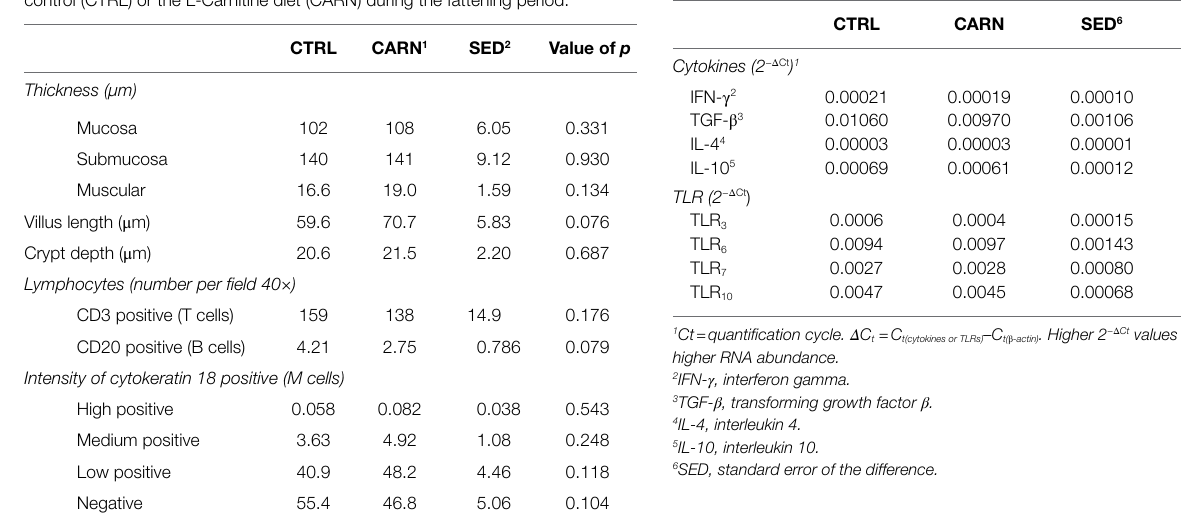
TABLE 9 | Cytokines and toll-like receptors (TLRs) mRNA expression in the ileal mucosa of early feed restricted lambs being fed the control (CTRL) or the L-Carnitine diet (CARN) during the fattening